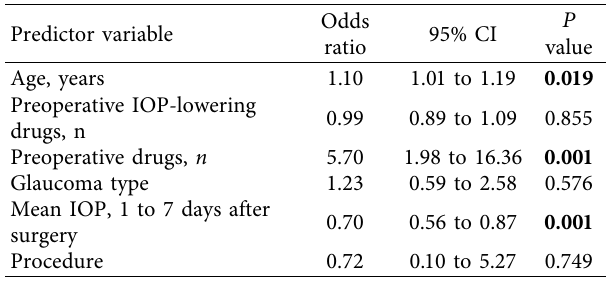
Table 3: Multivariate analysis results (factors associated with the occurrence of choroidal detachment after Xen gel stent surgery).